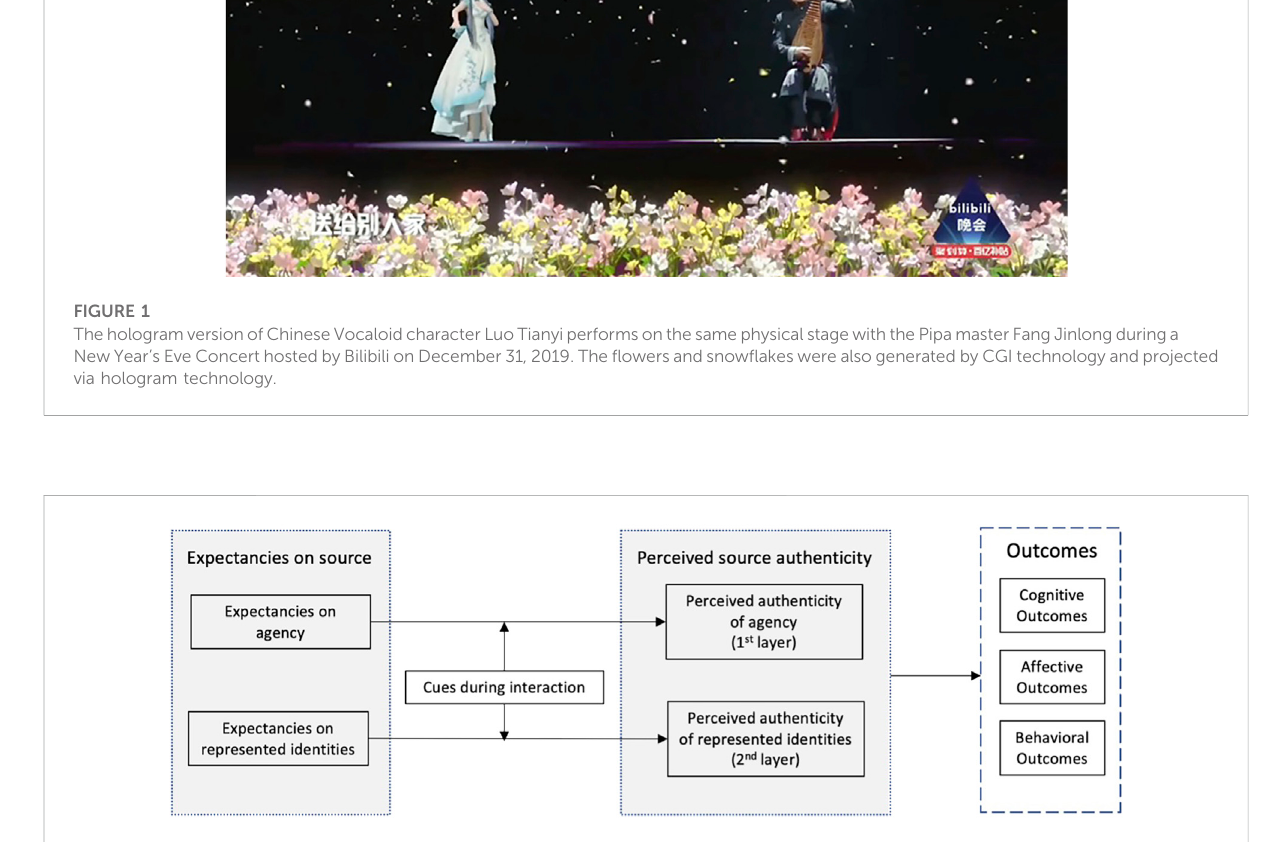
FIGURE 2 A multi-layered model of perceived source authenticity in people ’ s experience with virtual